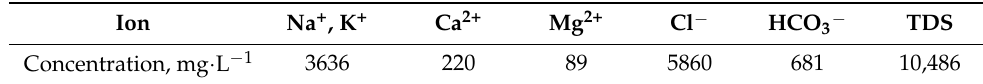
Table 1. Composition of the